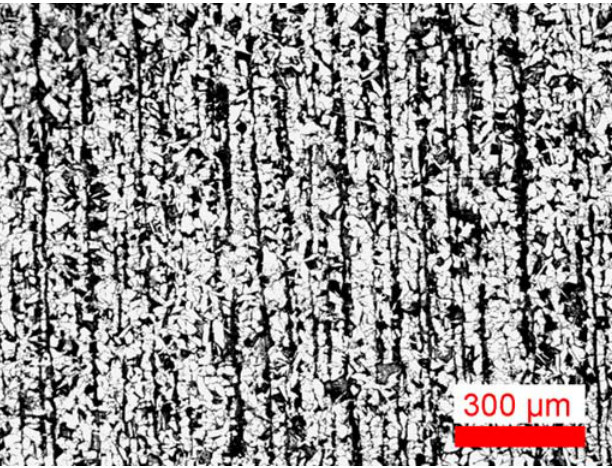
Figure 1: Optical micrograph of St-52-3N steel used in all tests.